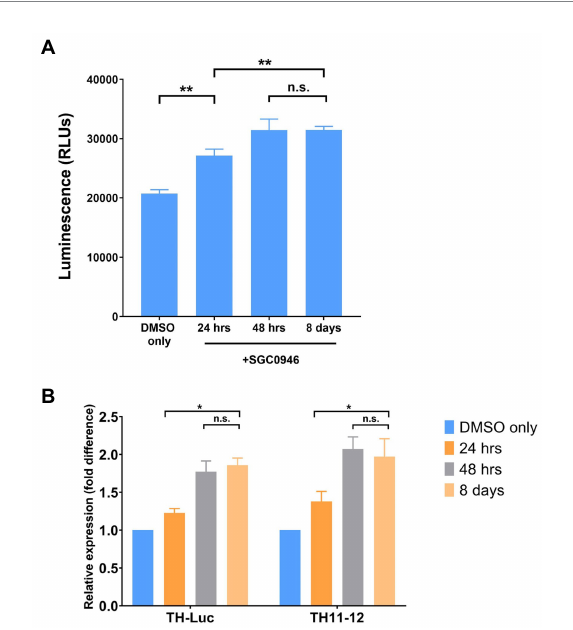
FIGURE 2 Tyrosine hydroxylase (TH) reporter activity. (A) TH expression by